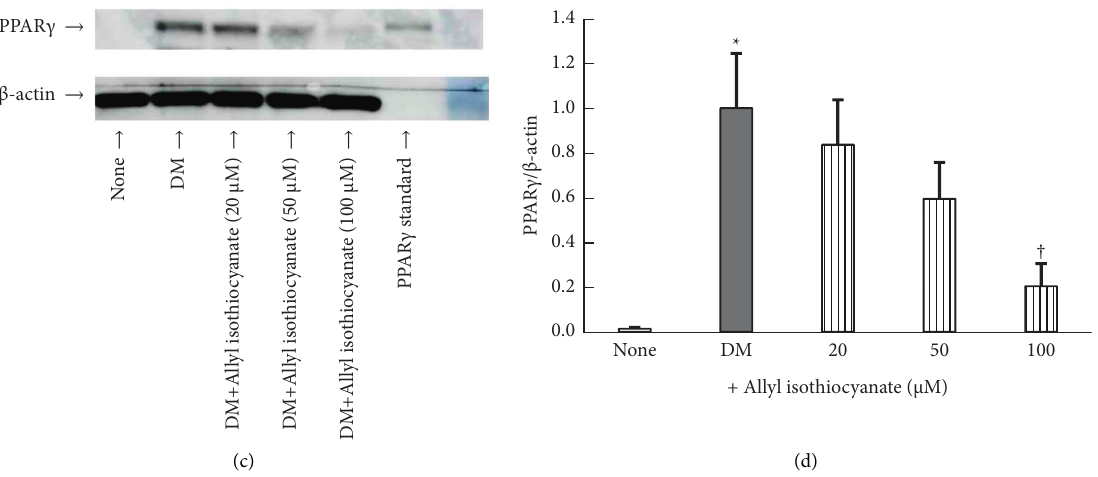
Figure 6: Peroxisome proliferator-activated receptor c (PPAR c ) protein levels in 3T3-L1 adipocytes treated with (a, b) sulforaphane or (c, d) allyl isothiocyanate. Data are presented as the mean ± standard error ( n � 4). ∗ denotes P < 0 . 01, versus untreated cells (none); † denotes P < 0 . 05; †† denotes P < 0 . 01, versus cells cultured in differentiation medium